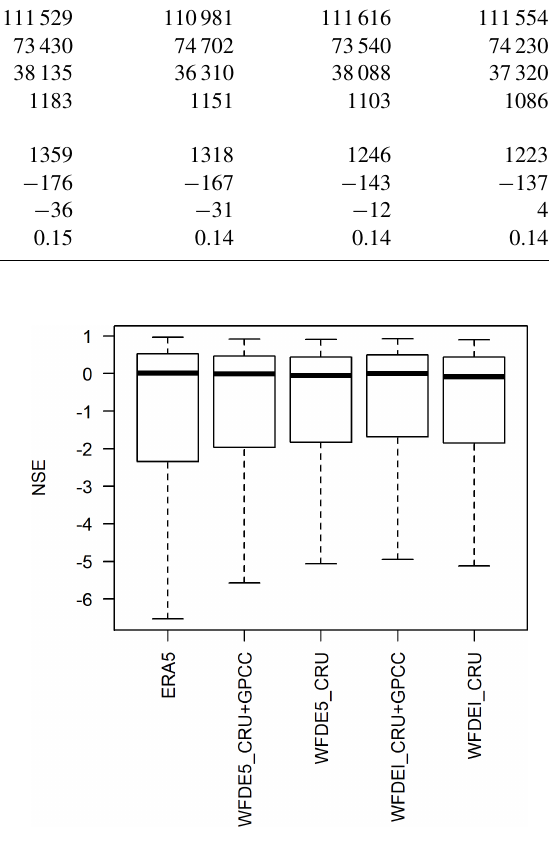
Figure 4. Model efficiency for the uncalibrated runs of the cli- mate forcings in this assessment using monthly time series of 1216 GRDC